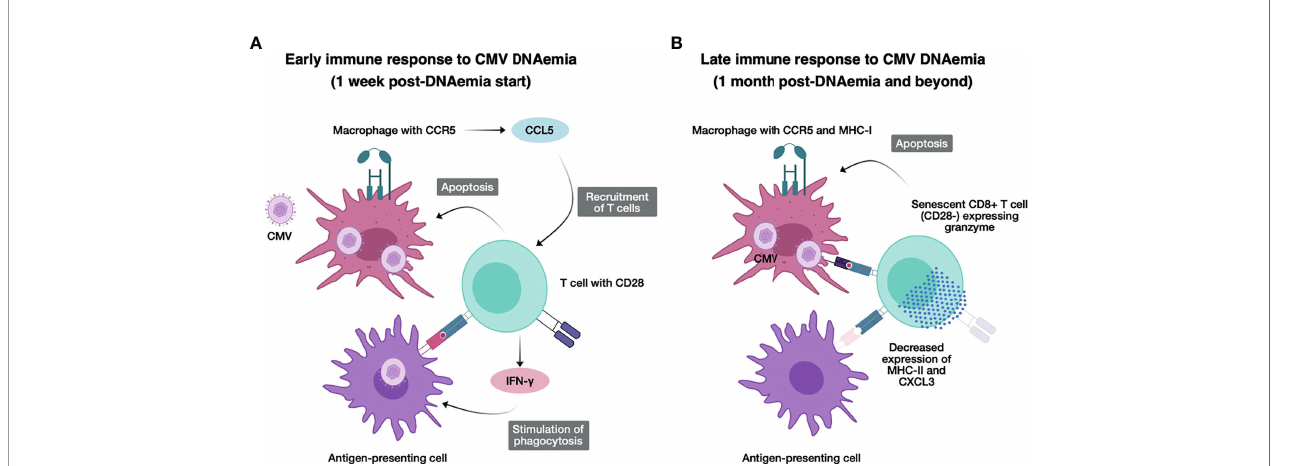
FIGURE 6 | Model for immunological changes early and late after CMV DNAemia. (A) Concept fi gure illustrating the early immune response to CMV DNAemia. Cells infected with CMV including macrophages expressing CCR5 secrete CCL5, recruiting additional T cells, and undergo apoptosis from activated CD28+ T cells, which secrete IFN-g and stimulate phagocytosis in antigen-presenting cells. (B) Concept fi gure illustrating the late immune response to CMV DNAemia. Persistently infected cells including macrophages continue to present CMV antigen to CD8+ T cells, which have now become senescent, expressing LAG3 but not CD28 − , and activating, expressing granzyme and triggering apoptosis in infected cells. Antigen-presenting cells have function impaired by decreased expression of MHC class II and